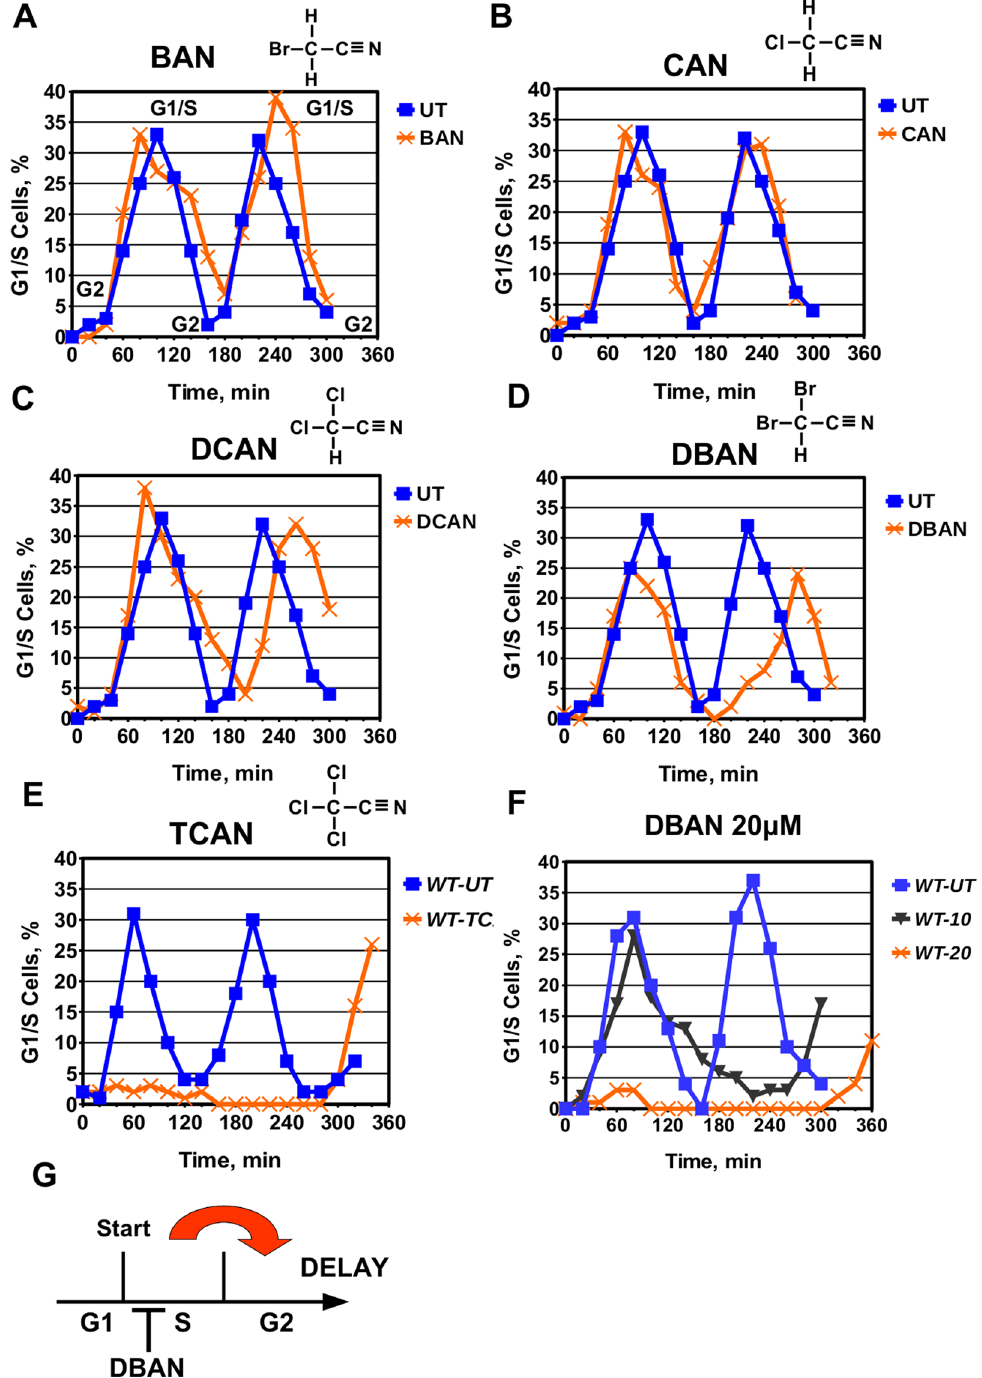
Figure 1. Dibromoacetonitrile (DBAN) arrests cell cycle progression in a concentration dependent manner. Wild type cells ( ade6-M210 leu1–32 ura4-D18 ) were synchronised in G2 by lactose gradient centrifugation 29 and released into rich medium (3% glucose, 0.5% yeast extract, 100 mg/L adenine) without (UT = untreated) or with 10 μ M of the indicated haloacetonitriles (HANs). All HANs were diluted from a 12 mM stock solution in DMSO to a final concentration of 10 μ M. ( A ) bromoacetonitrile (BAN), ( B ) chloroacetonitrile (CAN), ( C ) dichloroacetonitrile (DCAN), ( D ) dibromoacetonitrile (DBAN), ( E ) trichloroacetonitrile (TCAN), ( F ) DBAN at 10 μ M or 20 μ M. ( G ) DBAN affects cells in S phase which triggers a second cycle